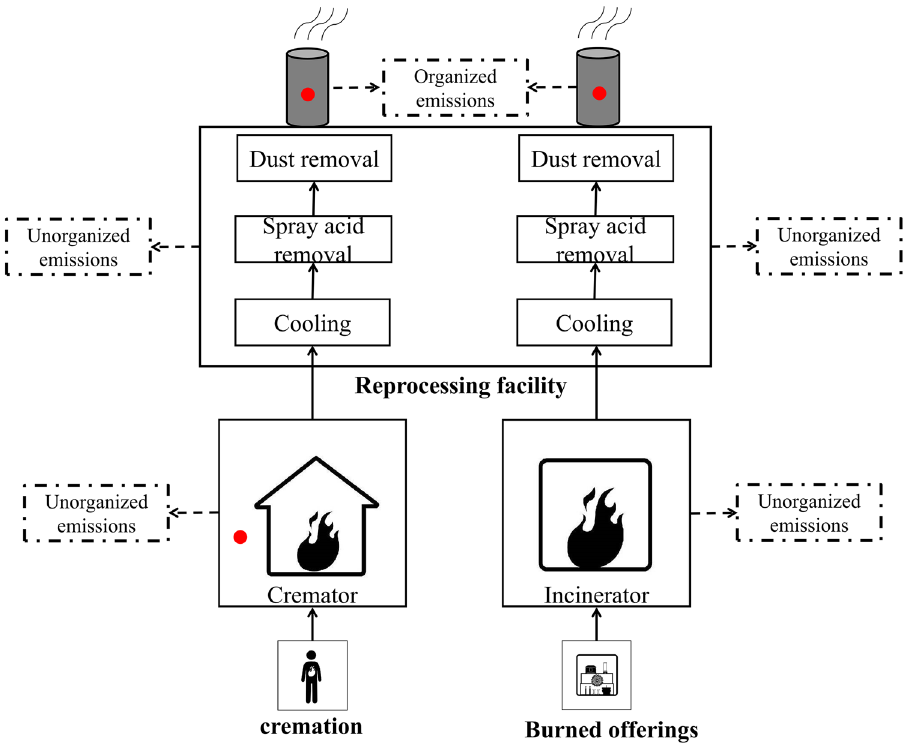
Fig. 2 The principle of crema- torium odor